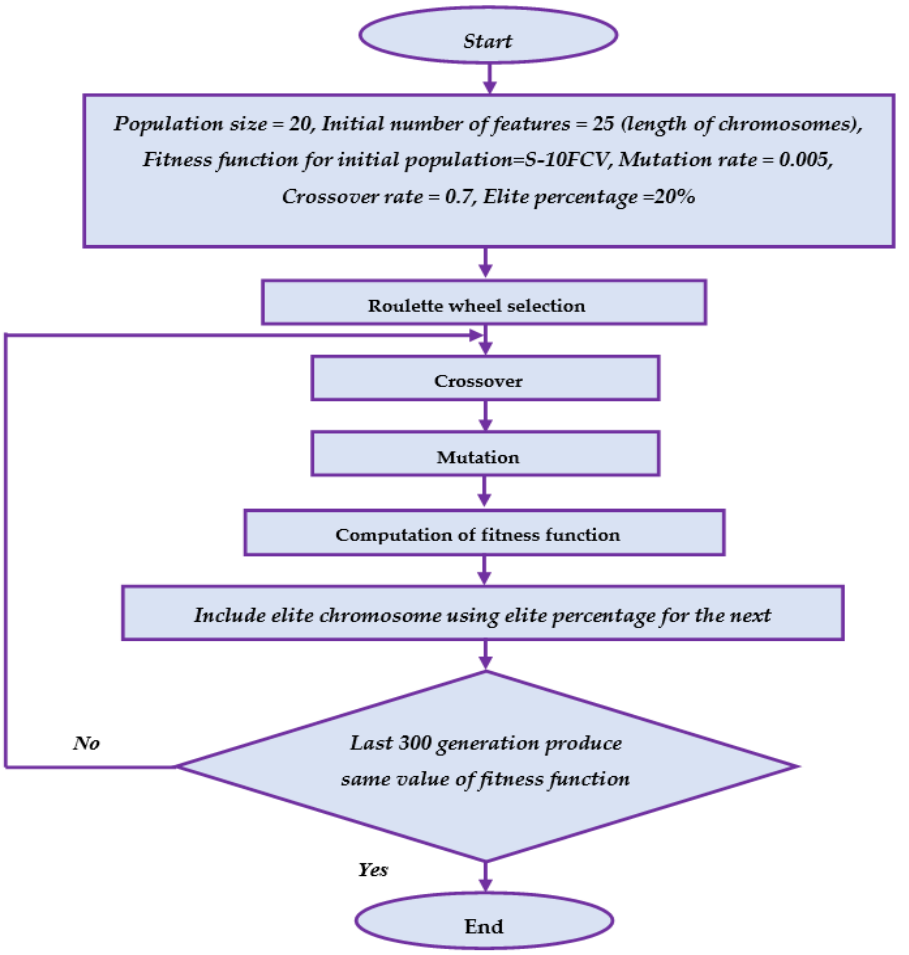
Figure 3. Flow chart for feature selection using the proposed novel hybrid algorithm.